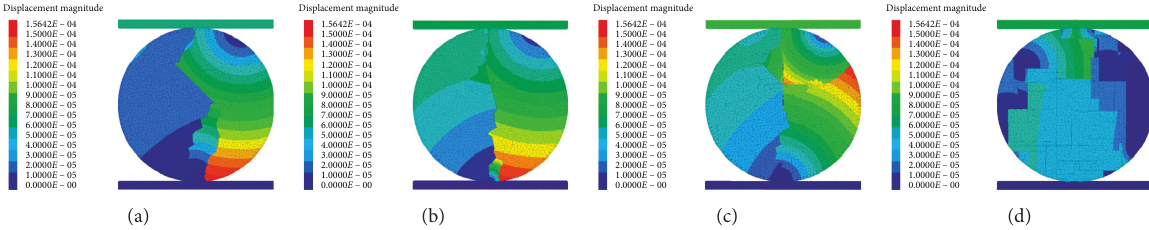
Figure 30: Splitting displacement cloud diagrams of shale with natural fractures. (a) 1 crack. (b) 2 cracks. (c) 3 cracks. (d) Natural crack grid.